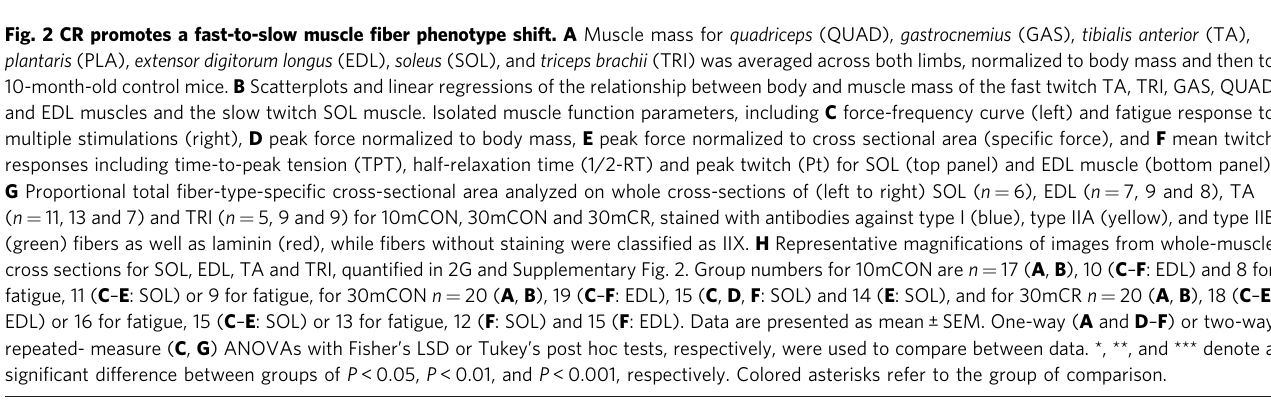
Fig. 2 CR promotes a fast-to-slow muscle fi ber phenotype shift. A Muscle mass for quadriceps (QUAD), gastrocnemius (GAS), tibialis anterior (TA), plantaris (PLA), extensor digitorum longus (EDL), soleus (SOL), and triceps brachii (TRI) was averaged across both limbs, normalized to body mass and then to 10-month-old control mice. B Scatterplots and linear regressions of the relationship between body and muscle mass of the fast twitch TA, TRI, GAS, QUAD and EDL muscles and the slow twitch SOL muscle. Isolated muscle function parameters, including C force-frequency curve (left) and fatigue response to multiple stimulations (right), D peak force normalized to body mass, E peak force normalized to cross sectional area (speci fi c force), and F mean twitch responses including time-to-peak tension (TPT), half-relaxation time (1/2-RT) and peak twitch (Pt) for SOL (top panel) and EDL muscle (bottom panel). G Proportional total fi ber-type-speci fi c cross-sectional area analyzed on whole cross-sections of (left to right) SOL ( n = 6), EDL ( n = 7, 9 and 8), TA ( n = 11, 13 and 7) and TRI ( n = 5, 9 and 9) for 10mCON, 30mCON and 30mCR, stained with antibodies against type I (blue), type IIA (yellow), and type IIB (green) fi bers as well as laminin (red), while fi bers without staining were classi fi ed as IIX. H Representative magni fi cations of images from whole-muscle cross sections for SOL, EDL, TA and TRI, quanti fi ed in 2G and Supplementary Fig. 2. Group numbers for 10mCON are n = 17 ( A , B ), 10 ( C – F : EDL) and 8 for fatigue, 11 ( C – E : SOL) or 9 for fatigue, for 30mCON n = 20 ( A , B ), 19 ( C – F : EDL), 15 ( C , D , F : SOL) and 14 ( E : SOL), and for 30mCR n = 20 ( A , B ), 18 ( C – E : EDL) or 16 for fatigue, 15 ( C – E : SOL) or 13 for fatigue, 12 ( F : SOL) and 15 ( F : EDL). Data are presented as mean ± SEM. One-way ( A and D – F ) or two-way repeated- measure ( C , G ) ANOVAs with Fisher ’ s LSD or Tukey ’ s post hoc tests, respectively, were used to compare between data. *, **, and *** denote a signi fi cant difference between groups of P < 0.05, P < 0.01, and P < 0.001, respectively. Colored asterisks refer to the group of